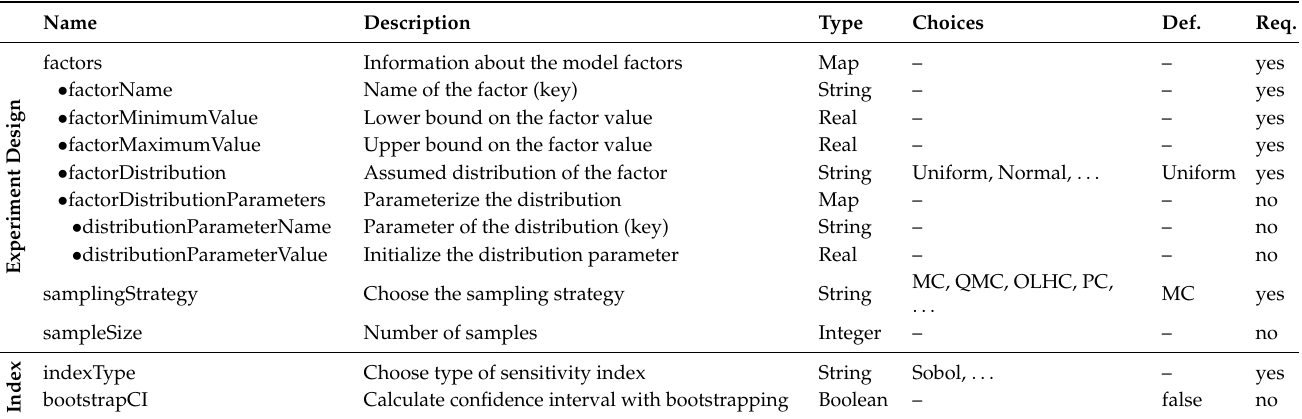
Table 3. Meta model for the experiment type “global sensitivity analysis” (including information about default values (Def.) and the required status (Req.)). To create a valid sensitivity analysis exper- iment, various information about the model factors has to be provided, as well as information about the sampling procedure (experiment design) and instructions for calculating the sensitivity